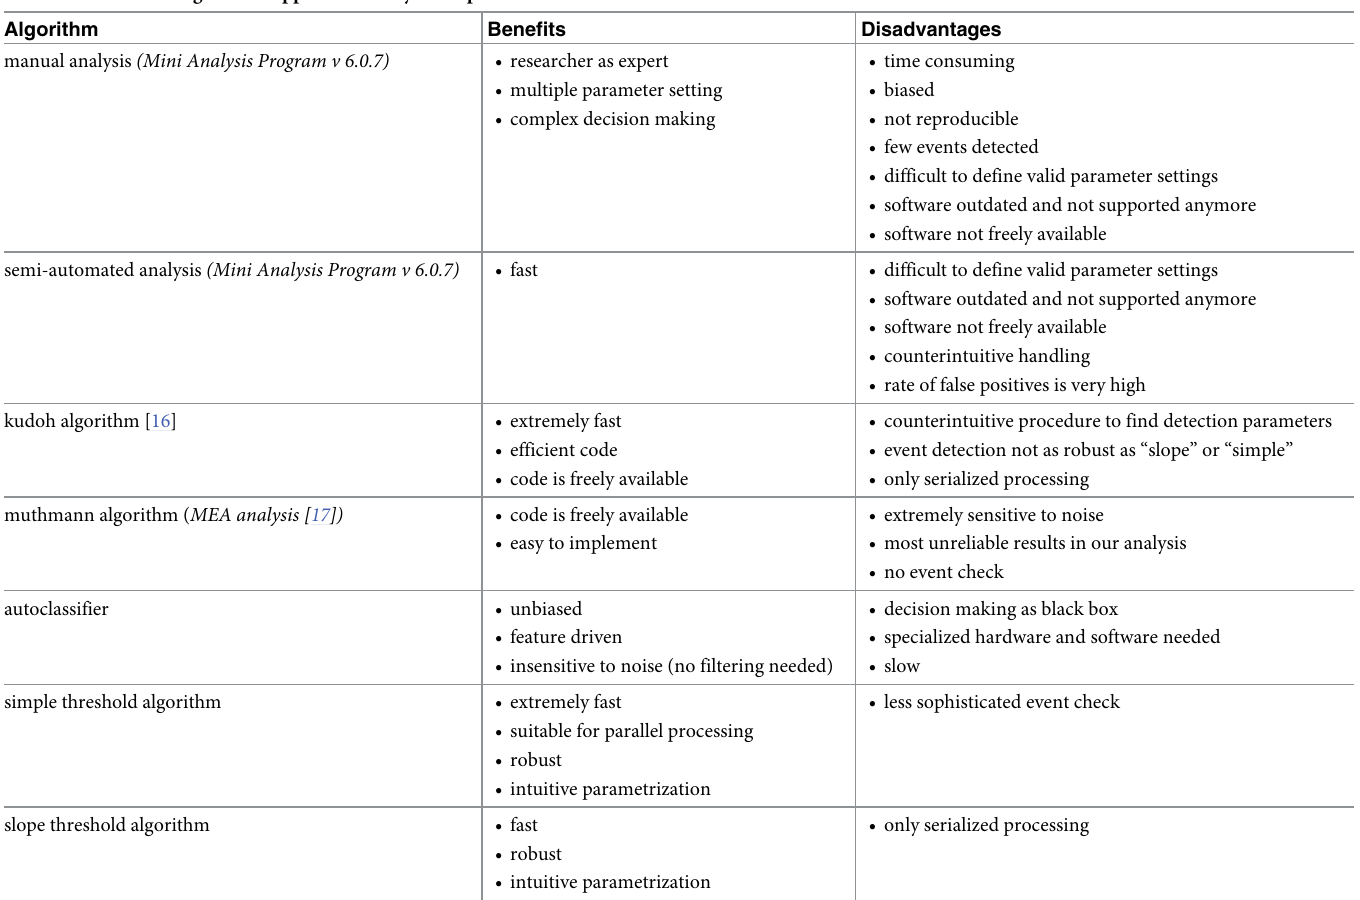
Table 2. Overview of algorithms applied for analysis of